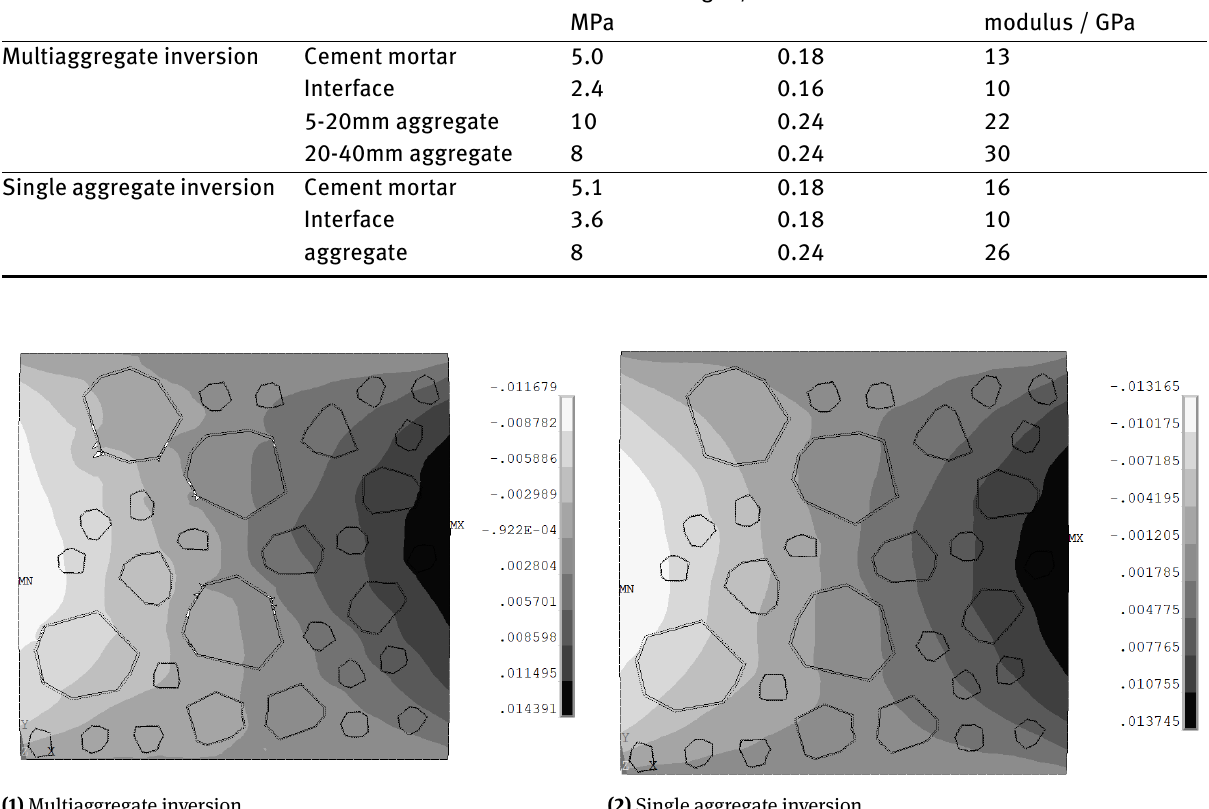
Figure 5: Horizontal displacement after six steps loading under different conditions (Unit:mm)